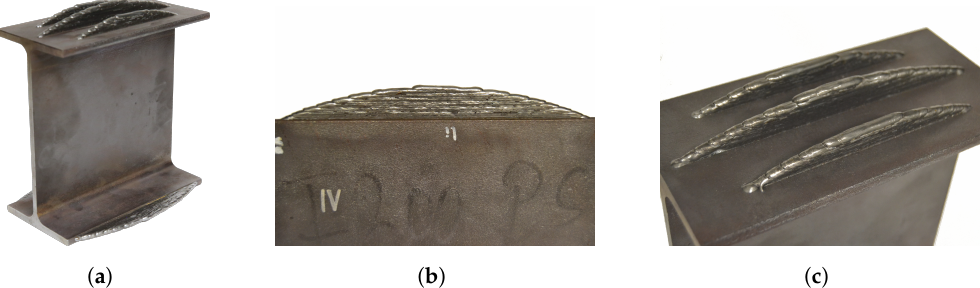
Figure 26. ( a ) Final demonstrator of IPE 200 profile with strengthened flanges; Detailed view reinforcement on ( b ) lower flange and on ( c ) upper flange.